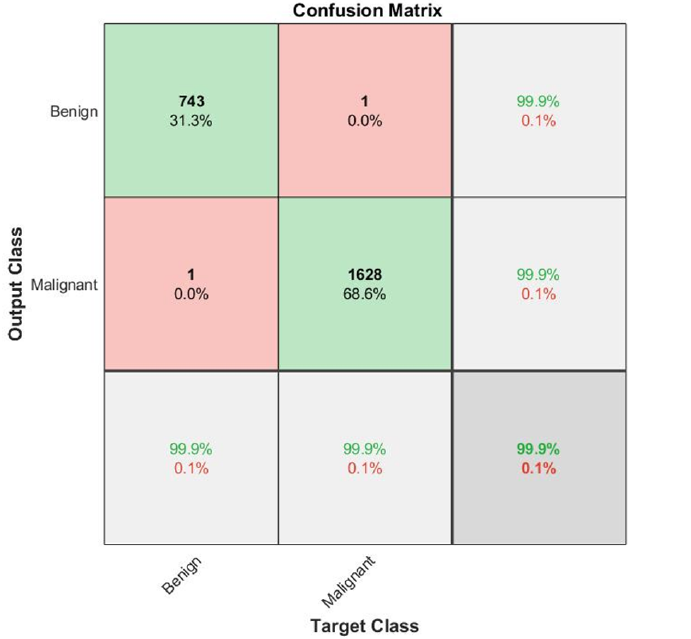
Figure 13. Confusion matrix displaying the performance of the proposed BoDMCF approach.